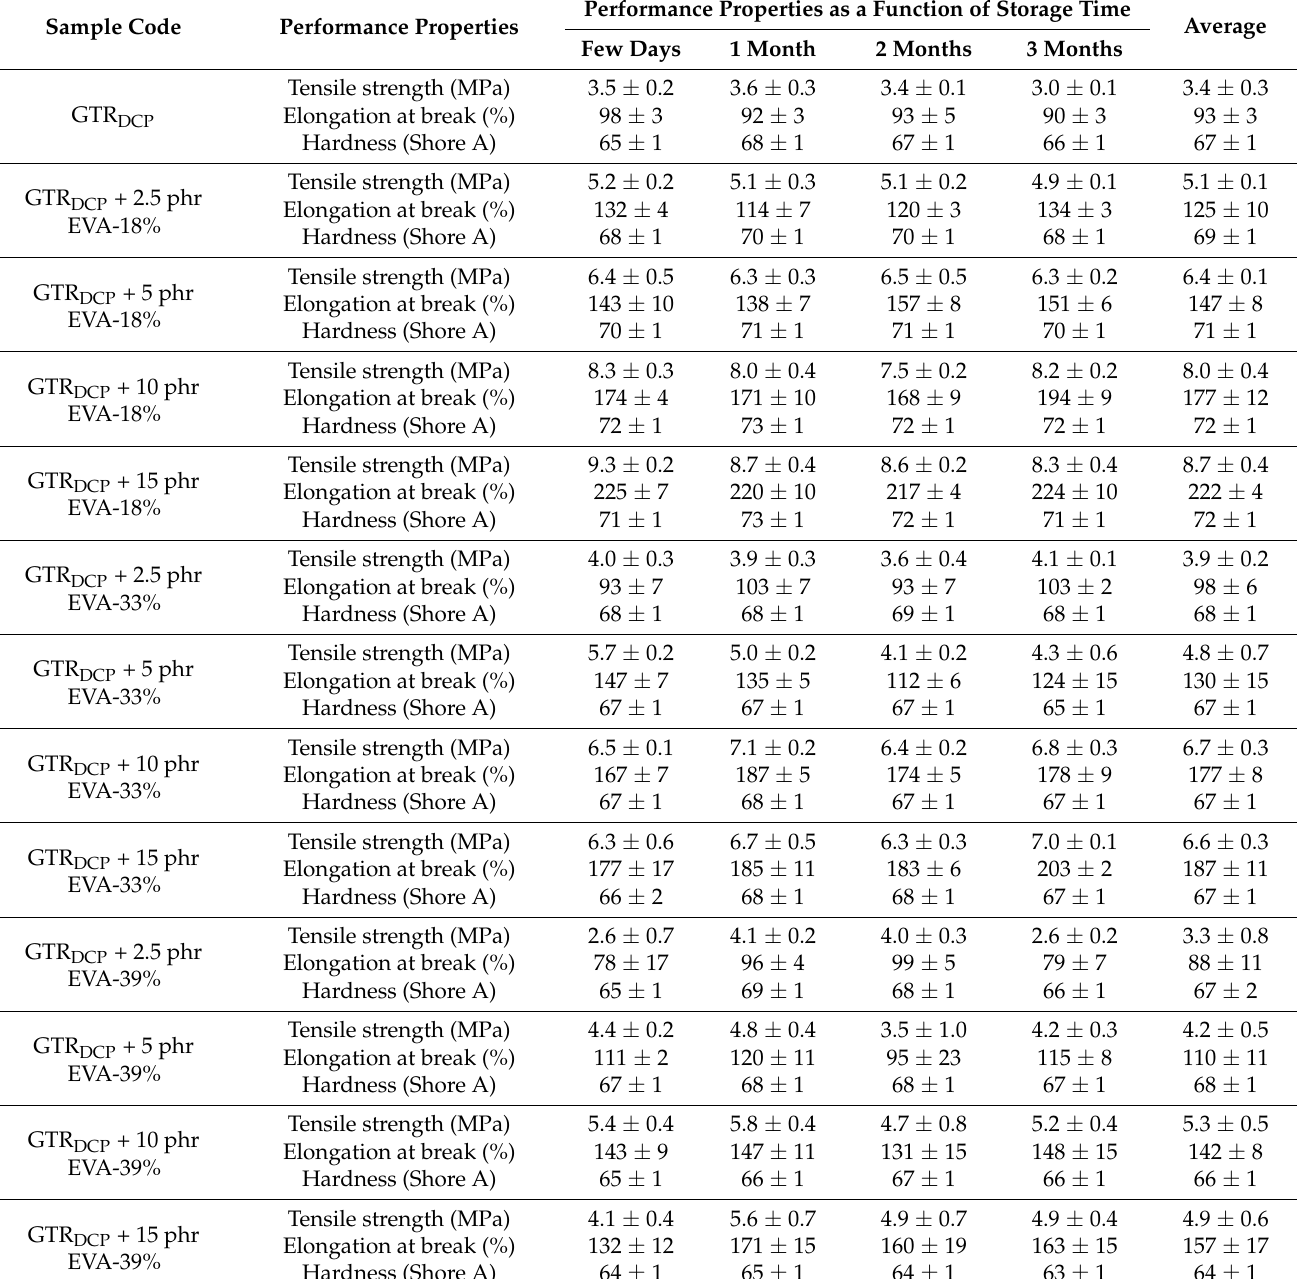
Table 7. Performance properties of modified GTR as a function of storage